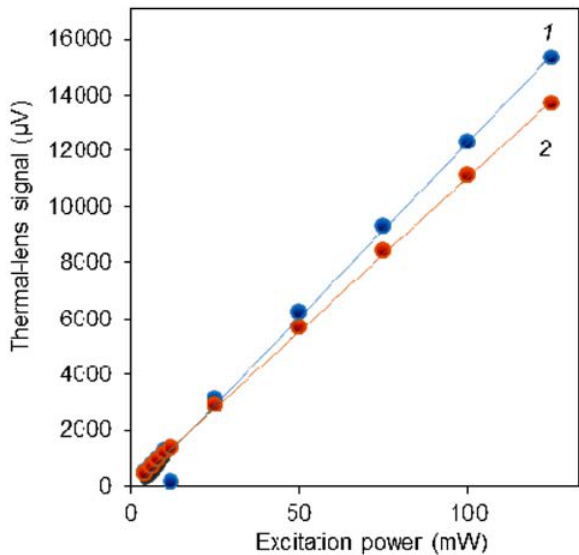
Figure 2. Dependence of the thermal-lens signal of Cr(VI) complex with diphenylcarbazide (4 μmol L –1 ) on the power of the excitation laser light for two flow rates, ( 1 ) 5 μL min –1 and ( 2 ) 30 μL min –1